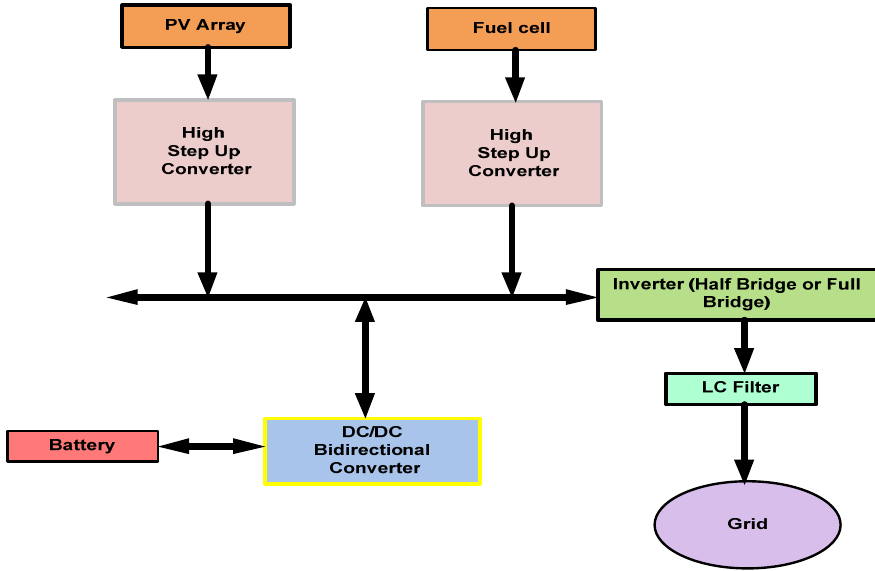
Figure 1. Block diagram of a hybrid renewable energy grid ‐ connected system.